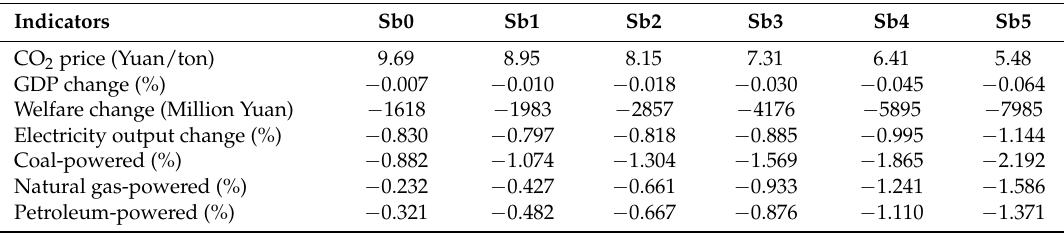
Table 10. Key results of sensitivity analysis (2007–2030 CO 2 intensity